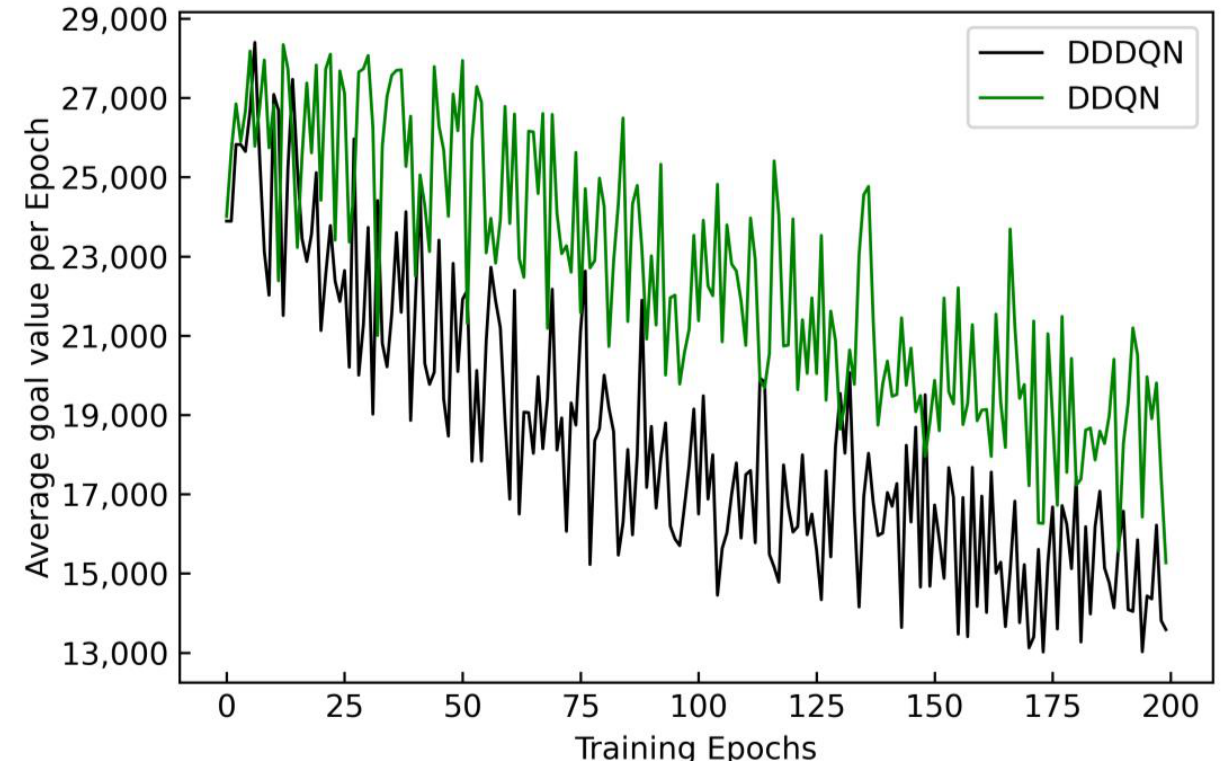
Figure 3. Comparison of the DDDQN with the DDQN.